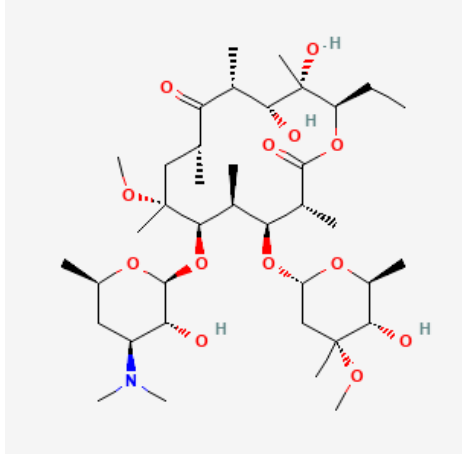
Figure 1. 2D chemical structure of clarithromycin.